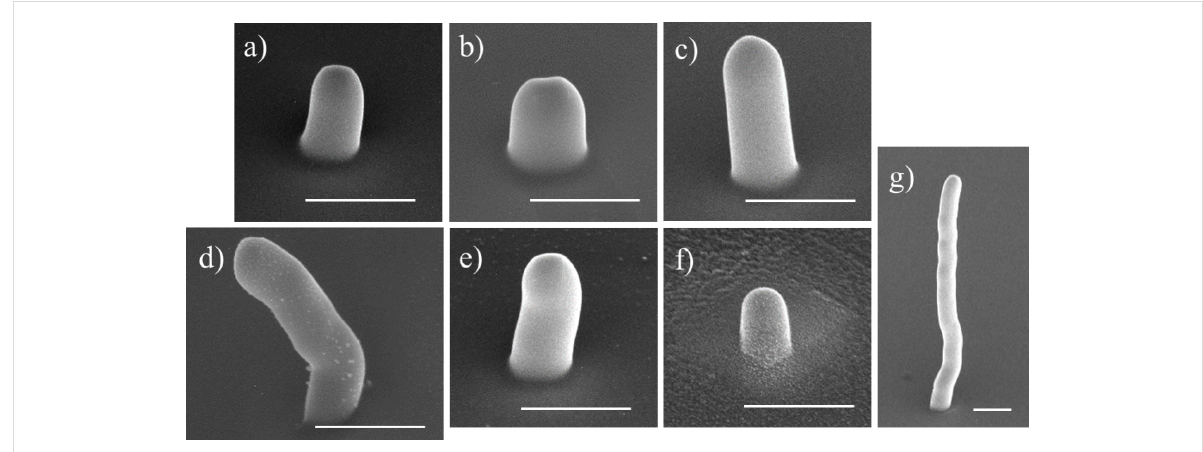
Figure 4: SEM images, tilted by 50°, of 250 × 250 nm 2 square deposits made using a beam energy and current of 5 keV and 40 pA, respectively. (a) 1 (Cl,Me)AuCl, (b) 2 (Cl,Et)AuCl, (c) 3 (Cl,iPr)AuCl, (d) 4 (Cl,Et)AuBr, (e) 5 (Cl,Et)AuI, (f) 6 (N,Et)AuCl, and (g) 7 (Cl,Et)AuCF 3 . The deposition was performed using the reservoir-on-substrate setup, heated to 100 °C for all compounds except for 1 , which was heated to 120 °C. The scale bars are 1